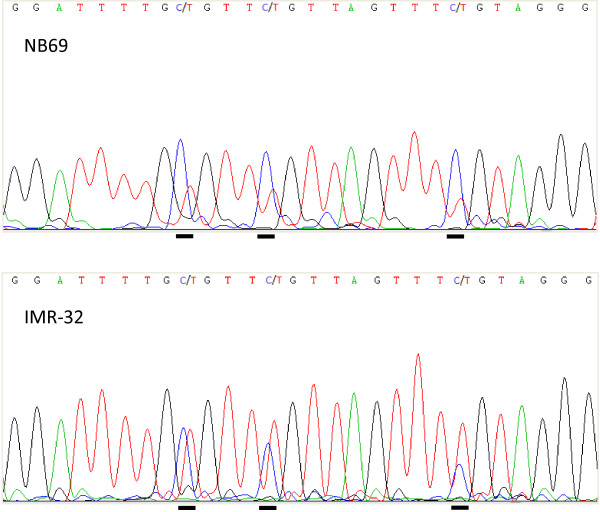
Bisulfite sequencing of RASSF7. Top sequence NB69 and bottom sequence IMR-32. Cytosines/thymines in the CpG dinucleotide are underlined. C in the sequence indicates methylation, C/T indicates partial methylation and T indicates unmethylated CpG sites.